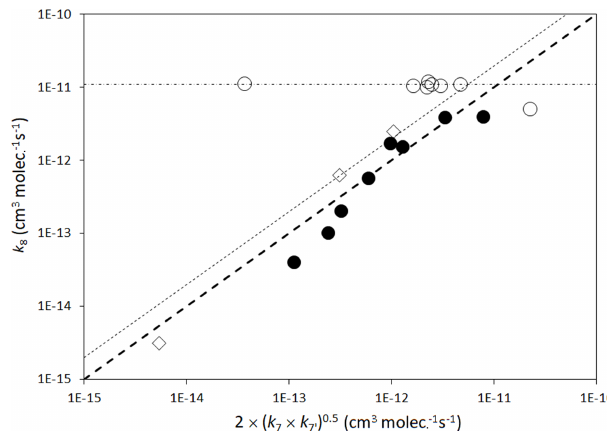
Figure 4. Scatter plot of estimated rate coefficients ( k RO peroxy radical self-reactions with those reported ( k 7 ), as listed in Tables 9 and 10. Those shown with reduced size symbols are where the reported value of k 7 was not corrected for secondary chem- istry (see Table 9 comments). The broken lines show the factor of 3 range.